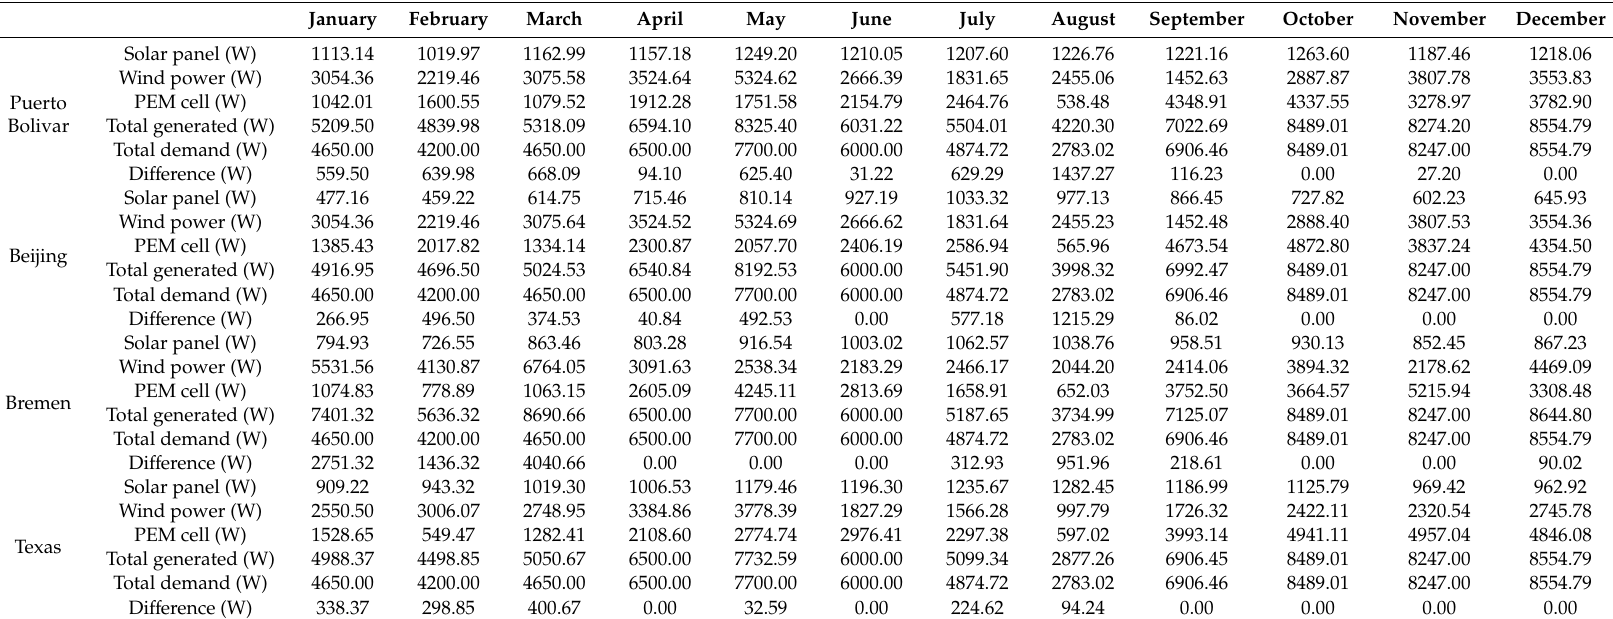
Table 6. Monthly generated renewable energy for demand